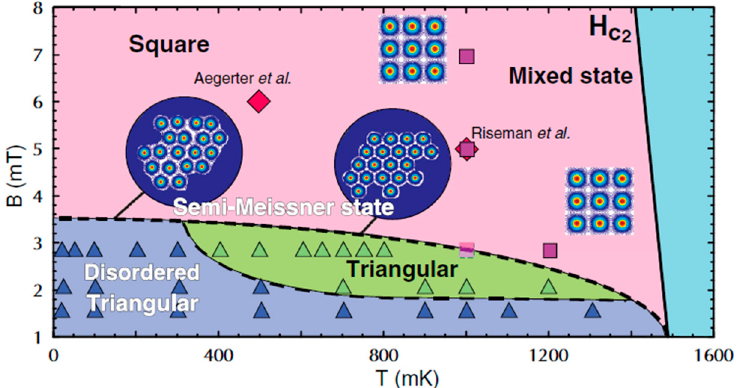
Figure 12. A vortex phase diagram of Sr